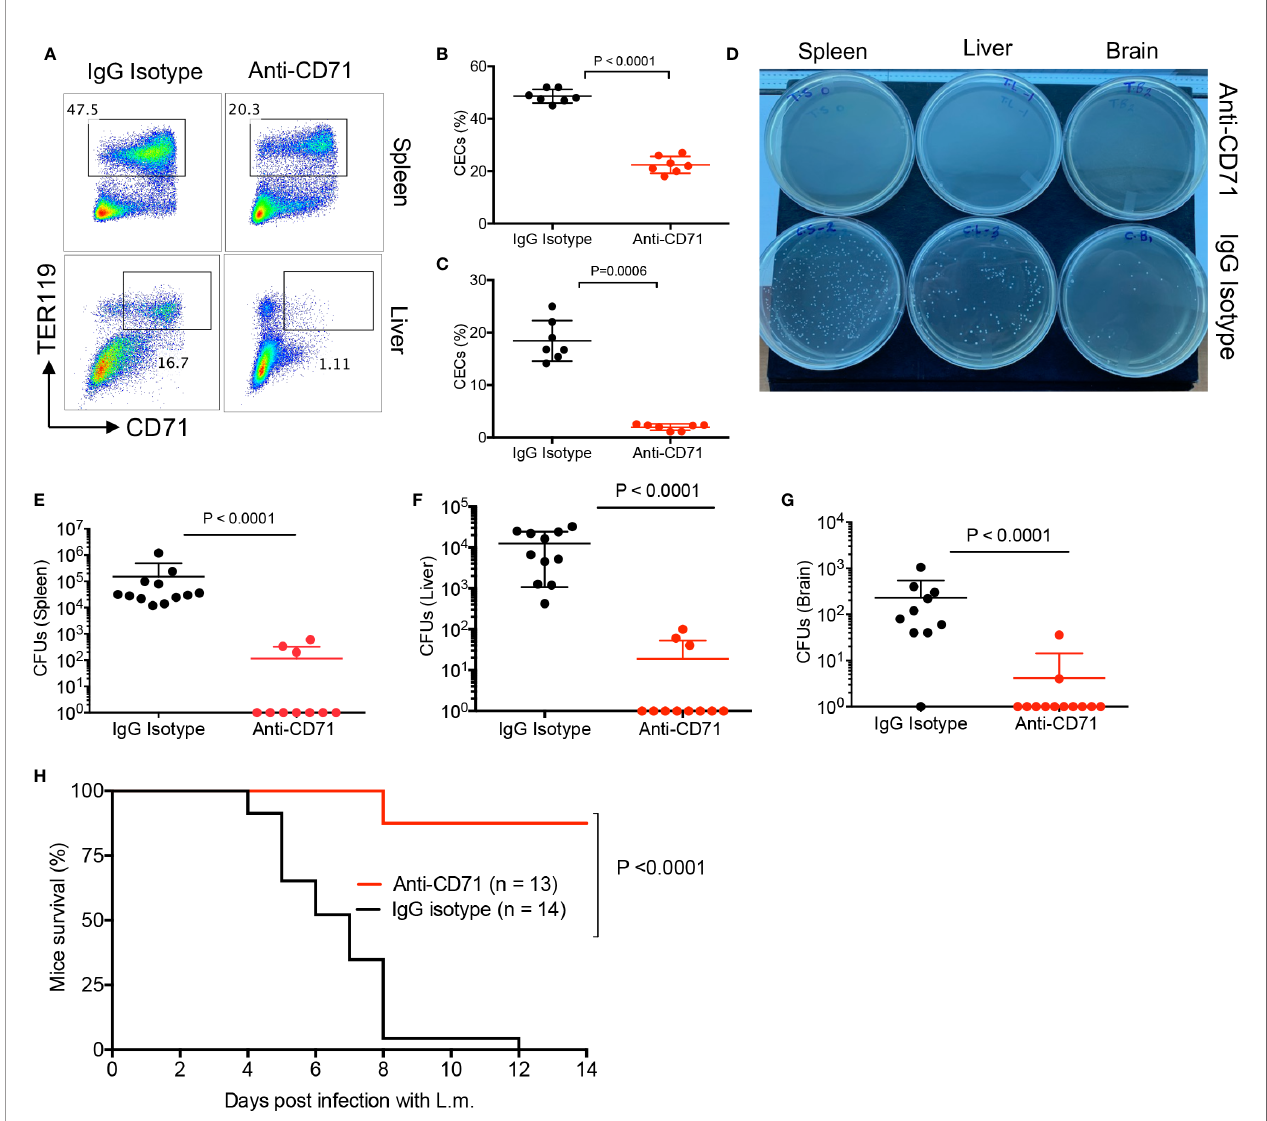
FIGURE 5 | The depletion of CECs reduces bacterial load in tissues. (A) Representative plots and (B) and (C) cumulative data showing quanti fi cation of CECs in the spleen and liver of mice following anti-CD71 or IgG2a isotype control administration (i.p.) at days 4 and 5, measured 2 days later. (D) Representative L.B plates comparing bacterial colonies in anti-CD71 treated versus IgG2a isotype control treated mice. (E) Cumulative data of Listeria monocytogenes colony forming units (CFUs) in the spleen, (F) liver, and (G) brain of mice either treated with anti-CD71 antibody or IgG2a isotype control. (H) Survival for neonate mice either treated with isotype control or anti-CD71 at days 4 and 5 then orally administered with 1 × 10 7 CFUs Listeria monocytogenes at day 6, and monitored over 2 weeks. Differences in mean values analyzed by two-tailed Student ’ s t test; p value is shown; N > 7/group, from at least two